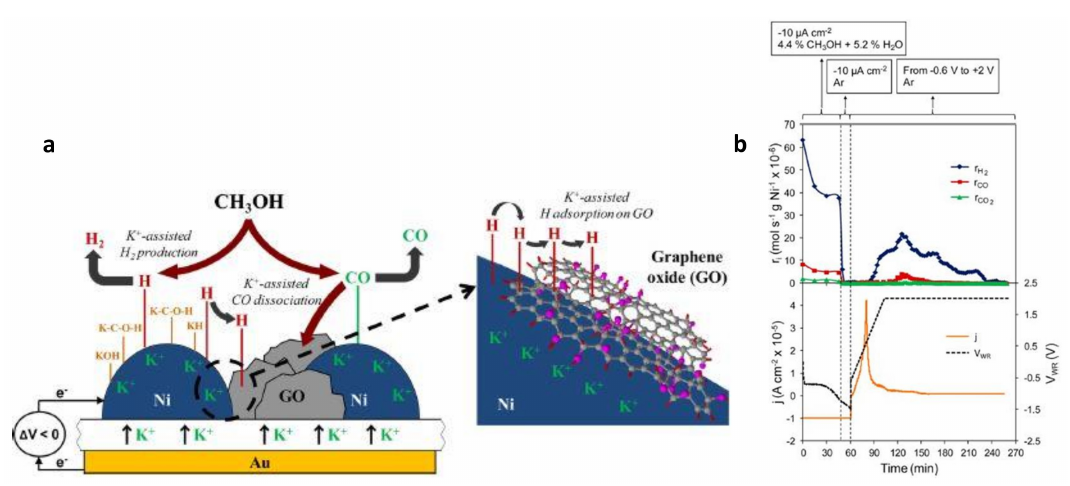
Figure 6. Potassium-promoted H 2 production and storage mechanism with a Ni / K + - β ”Al 2 O 3 electrochemical catalyst ( a ). Profiles of current density (j), catalyst potential (V WR ), H 2 , CO and CO 2 molar flow rates vs. time during a H 2 storage experiment at 1 atm and 280 ◦ C ( b ). H 2 production /